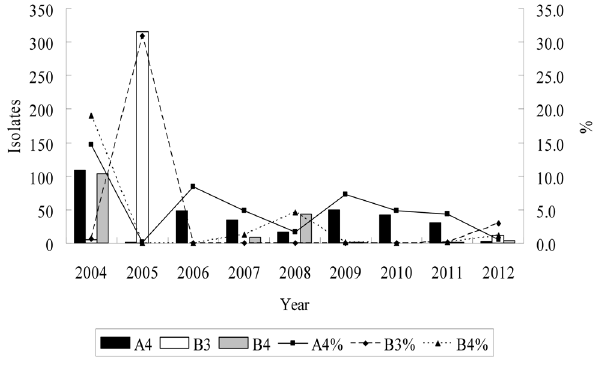
Figure 2. Isolates and percentage of Coxsackie A4, B3 and B4 isolates from January, 2004 to June, 2012 in Chang Gung Memorial Hospital, Taiwan.